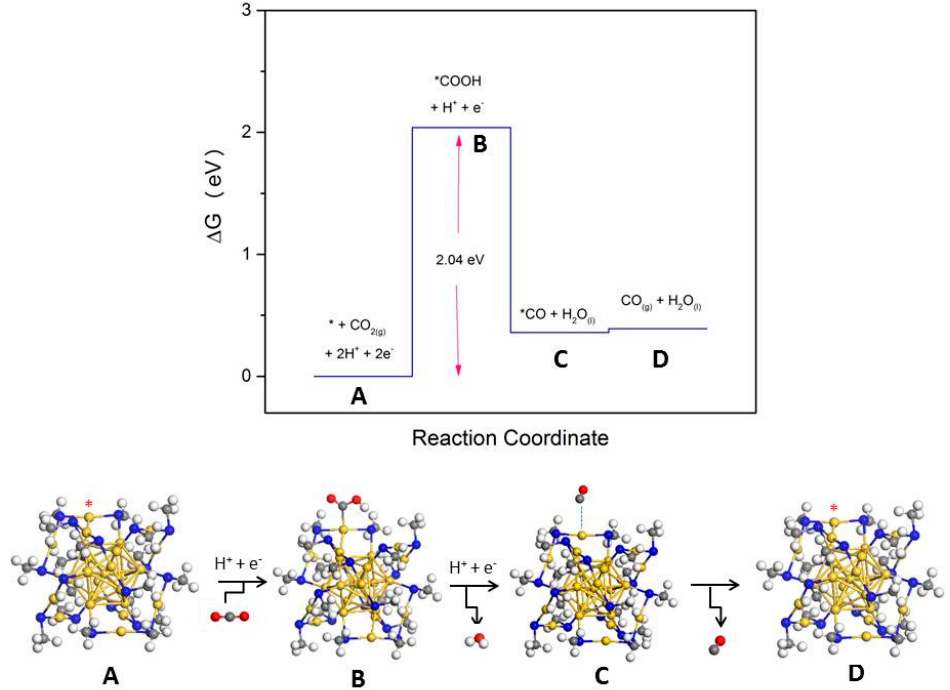
Figure 1. Free energy diagram for electrochemical reduction of CO 2 to CO on the intact cluster at T = 298 K, pH = 0 and zero applied potential. White, gray, blue, gold and red balls represent H, C, S, Au atom and O atoms, respectively. Reprinted from Ref. [28] with the permission of AIP Publishing. Copyright (2016) AIP